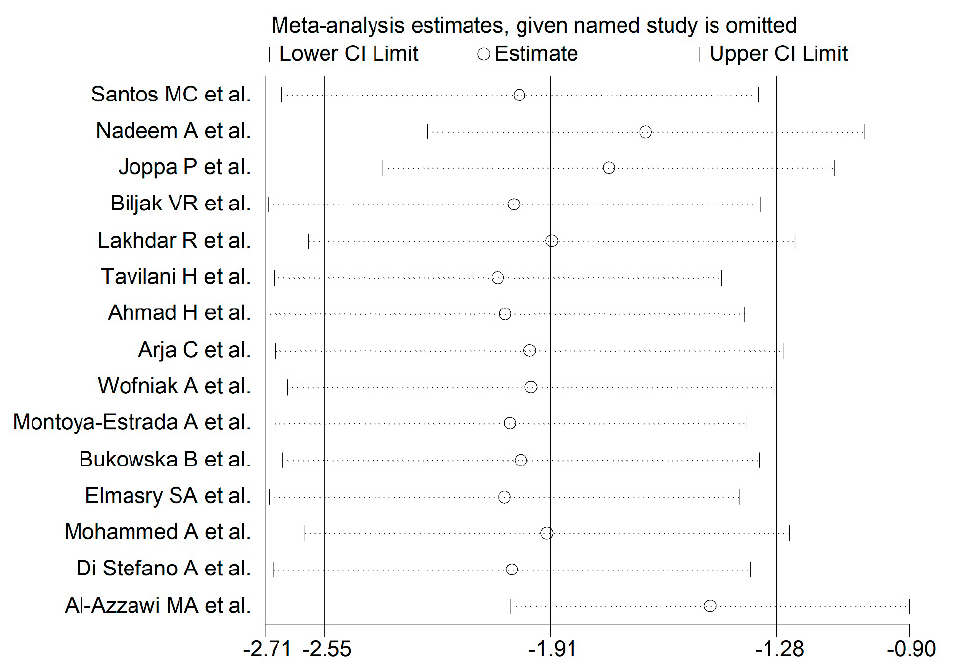
Figure 3. Sensitivity analysis of the association between blood/erythrocytes GPx and COPD disease. For each study, the displayed effect size (hollow circles) corresponds to an overall effect size computed from a meta-analysis excluding that study.